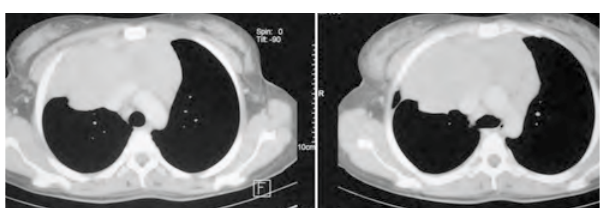
Fig. 9. Axial CT image in a 30-year-old man showing complex anterior mediastinal mass containing cystic, fat and soft-tissue components in a case of mature teratoma.